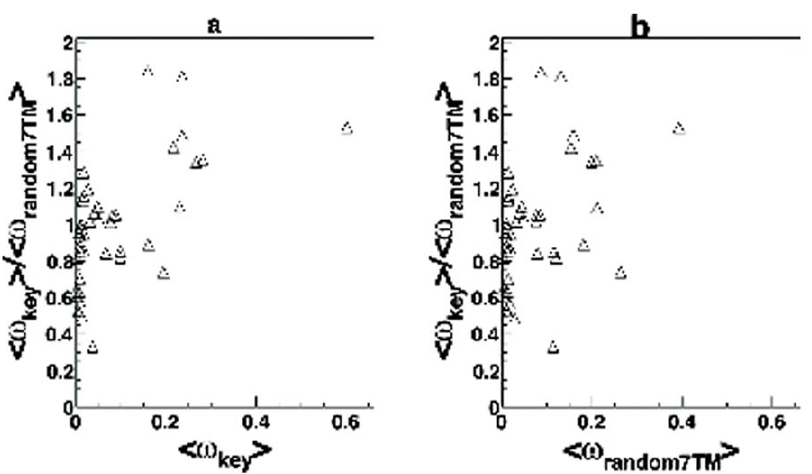
Figure 3. Graph showing the trends in , v key . / , v random7TM . vs. , v . . Subgroups with pair-wise max( d N ) , 1 are represented in these panels. Subgroups 38 and 44 are excluded to avoid bias due to positive selection. a ) Plot of , v key . / , v random7TM . vs. , v key . . b ) Plot of , v key . / , v random7TM . vs. , v random7TM . .